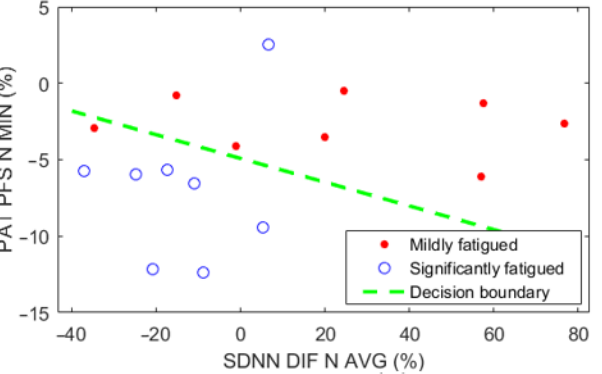
Figure 7. Linear SVM model for binary classification between the mildly fatigued and significantly fatigued groups.